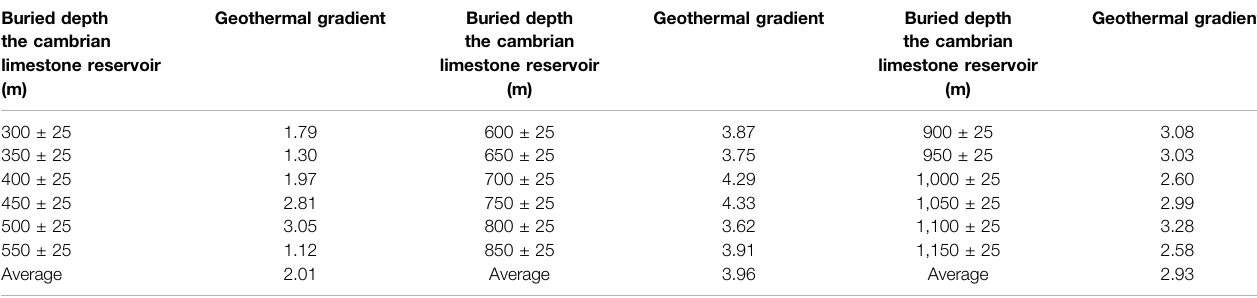
TABLE 4 | Geothermal gradients at different burial depths ( ° C/100 m).